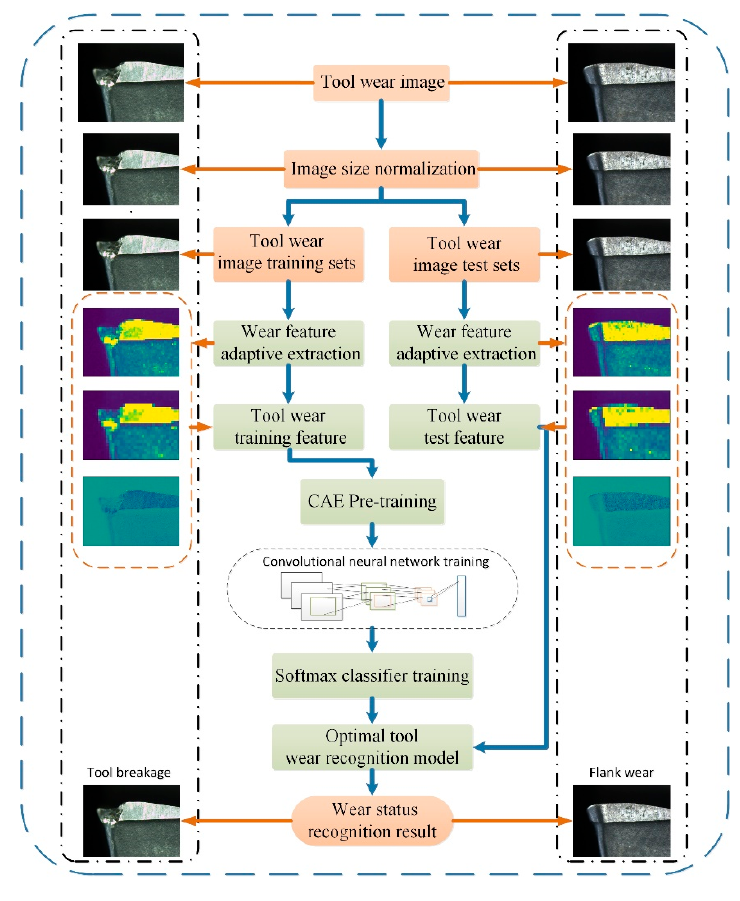
Figure 3. The overall process for tool wear identification.